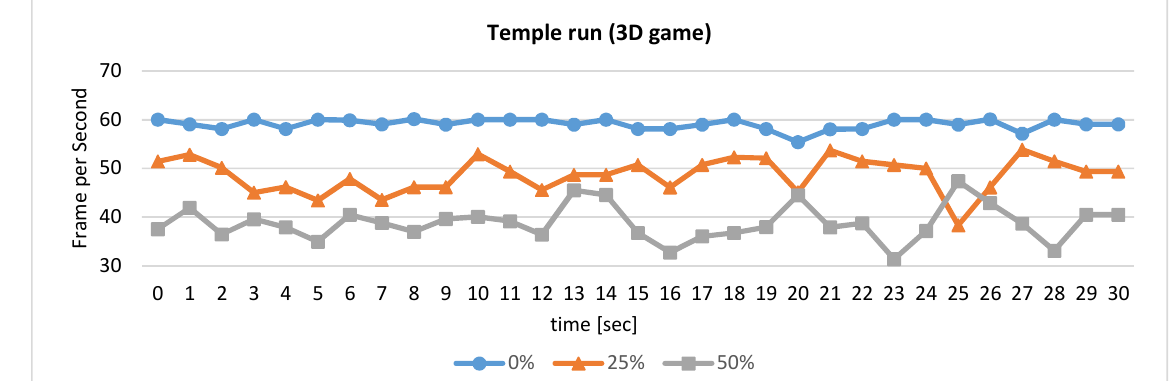
Figure 7. Frame per second (FPS) traces with different target